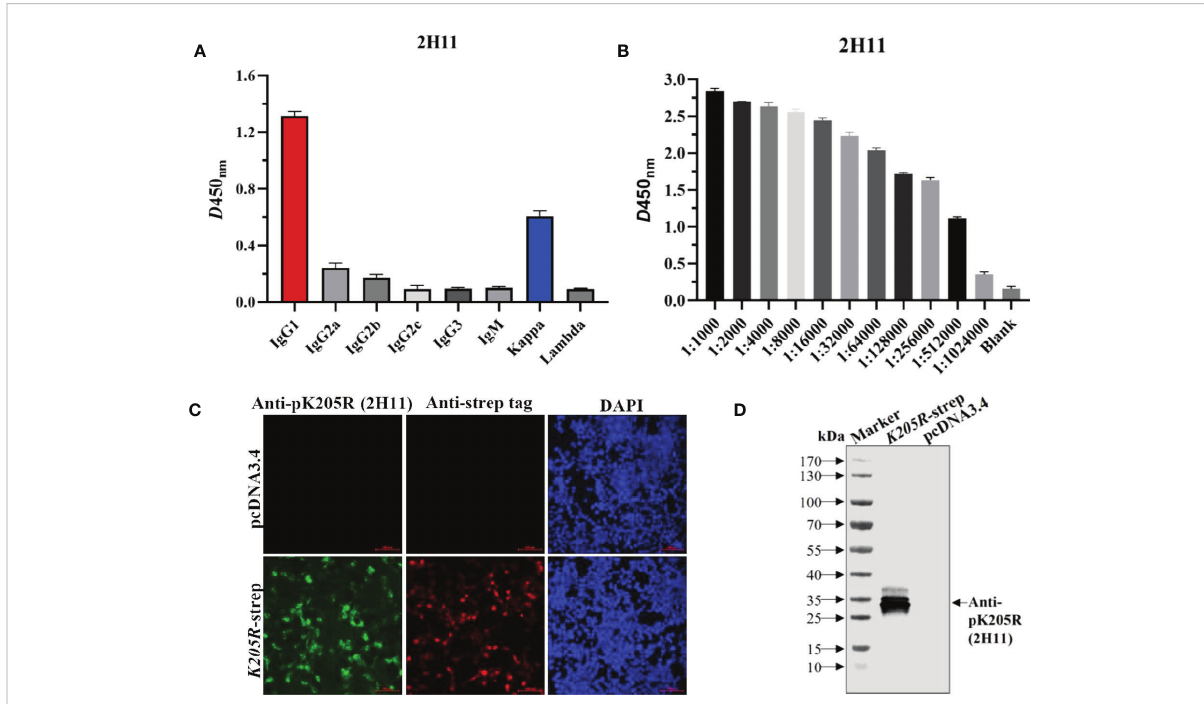
FIGURE 2 The anti-pK205R mAb (2H11) speci fi cally recognized 293i suspension cells transiently transfected with K205R -expressing plasmid. (A) Identi fi cation of the mAb subtypes and. (B) Identi fi cation of antibody titer of the puri fi ed 2H11 by the ELISA method. (C) 293T cells were transfected pcDNA3.4- K205R . Cells were fi xed at 24 h post-transfection and immunostained with 2H11 and FITC-conjugated goat anti-mouse IgG. Cellular nuclei were counterstained with 1 m g/ml of 4 ′ ,6 ′ -diamidino-2-phenylindole (DAPI). (D) WB assay was conducted as treated in (C) to show the reactivity of